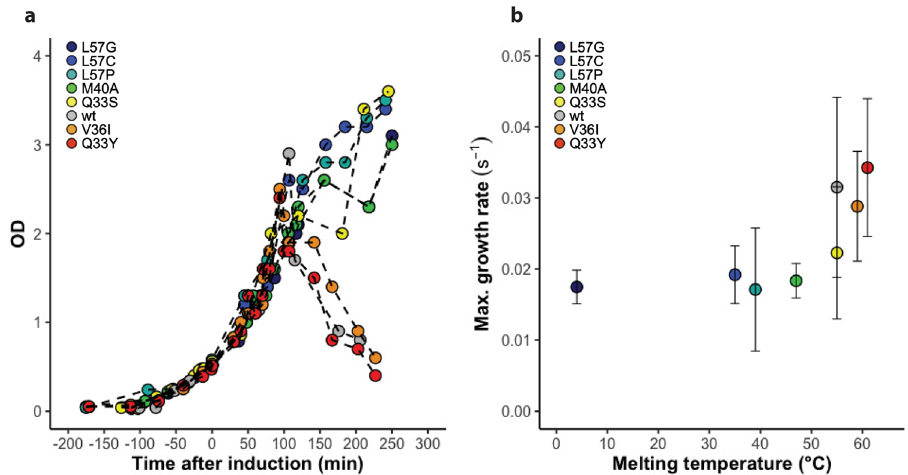
Fig. 2 Growth of cells expressing N102LT variants. a OD 600 as a function of time after induction of protein synthesis for cells expressing the variants: L57G (dark blue), L57C (blue), L57P (cyan), M40A (green), Q33S (yellow), V36I (orange), Q33Y (red) and wt (grey). One of three replicates is shown for each variant. b Maximum cell growth rates are estimated based on fi tting logistic growth models and extracting the maximum rate. Errors bars represent the uncertainty due to the fi tting of a growth model to the